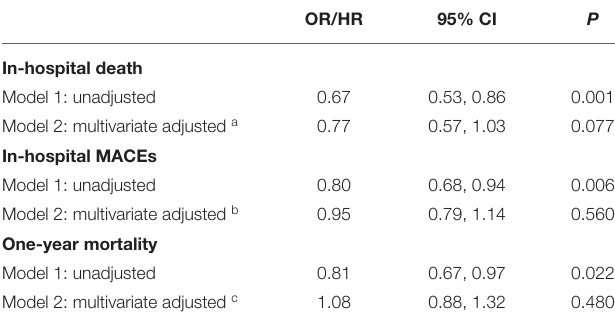
TABLE 3 | Unadjusted and adjusted OR/HR of